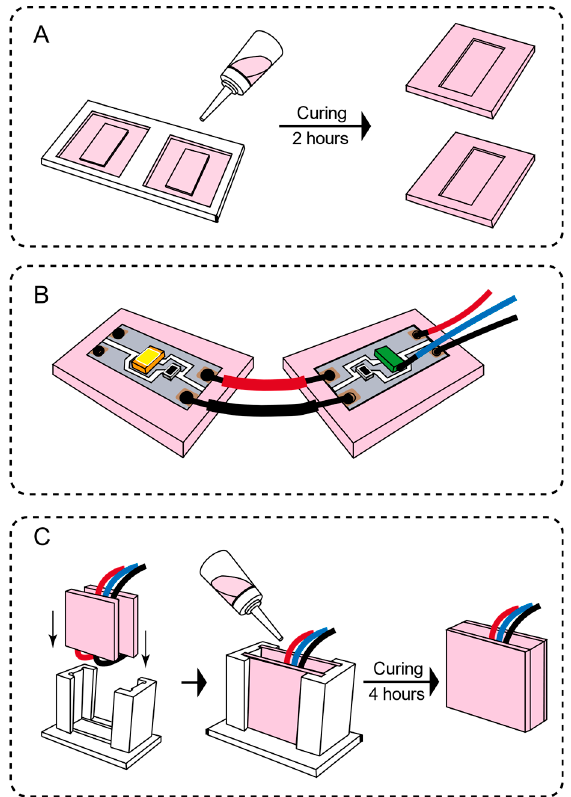
Figure 3. The integration process of the flexible module of the sensing unit. ( A ) Silica gel baffle pouring ( B ) The sensor unit is fixed on the silica gel baffle ( C ) Put into the mold and add the silica gel mixture to wait for solidification